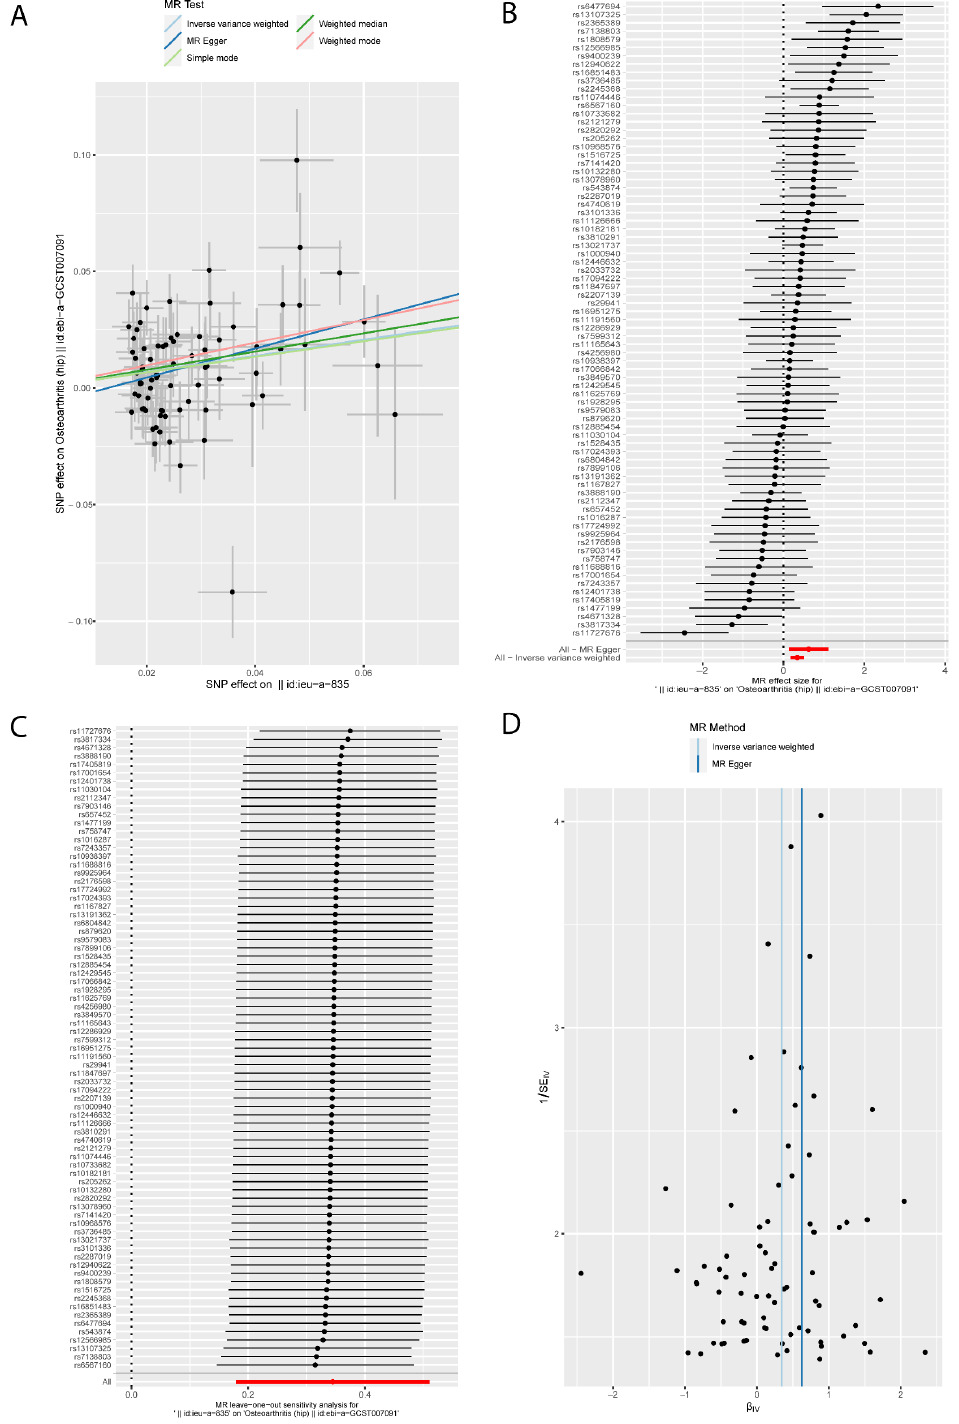
Figure 3. The MR results of body mass index on hip osteoarthritis. ( A ) Scatter plot about the causal effect of body mass index on hip osteoarthritis. ( B ) Forest plot for the overall causal effects of body mass index on hip osteoarthritis. ( C ) Leave-one-out analysis for the causal effect of body mass index on hip osteoarthritis. ( D ) Funnel plot of SNPs related to body mass index and hip